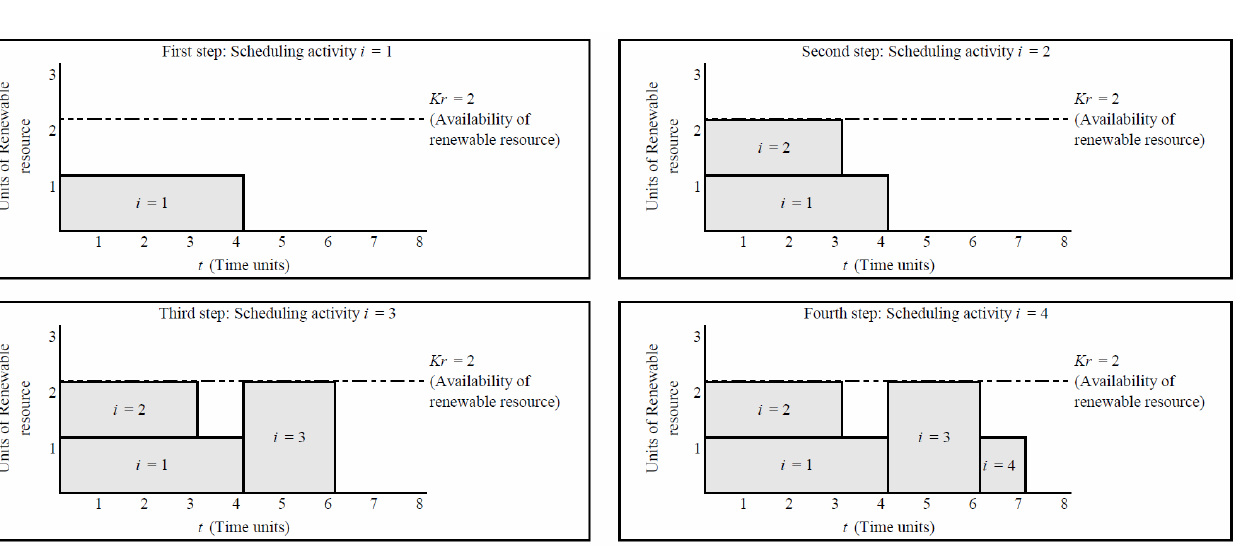
Figure 3. Step by step scheduling of a solution for a sample project following a serial schedule generation scheme (SGS)